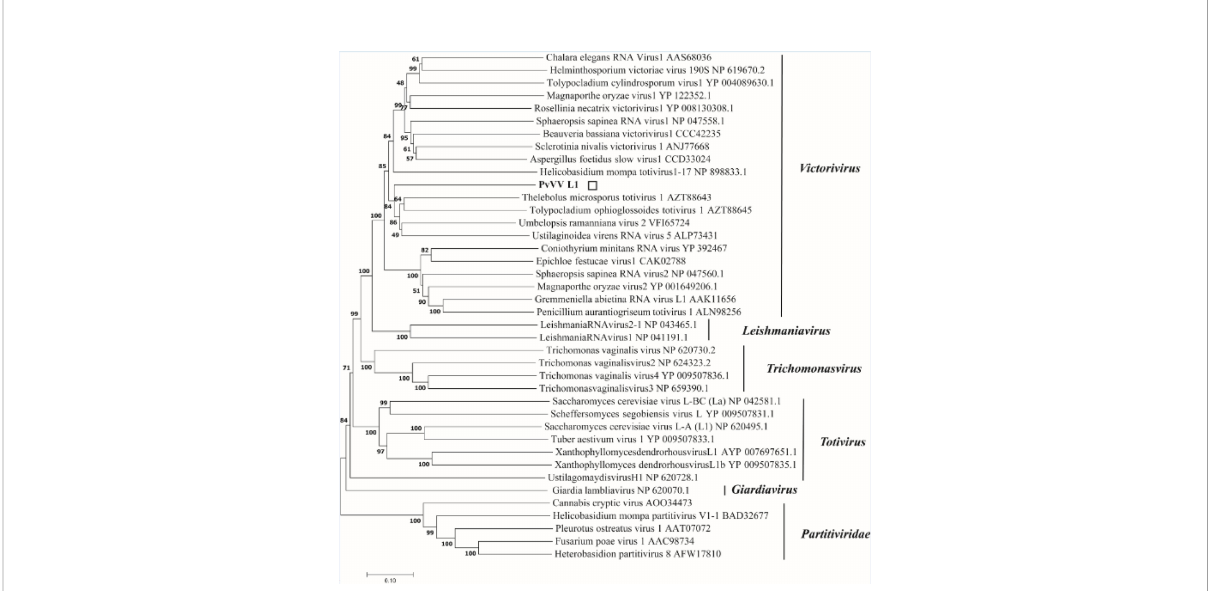
FIGURE 16 Phylogenetic analysis of PvVVL1. Phylogenetic analysis illustrating the evolutionary classi fi cation of PvVVL1 was conducted using the method described in Figure 7. The scale bar represents a genetic distance of 0.1 aa substitutions per site. The white square indicates the novel mycovirus PvVVL1 in the present study. The names and database accession numbers of other related viruses analyzed are indicated in the tree.